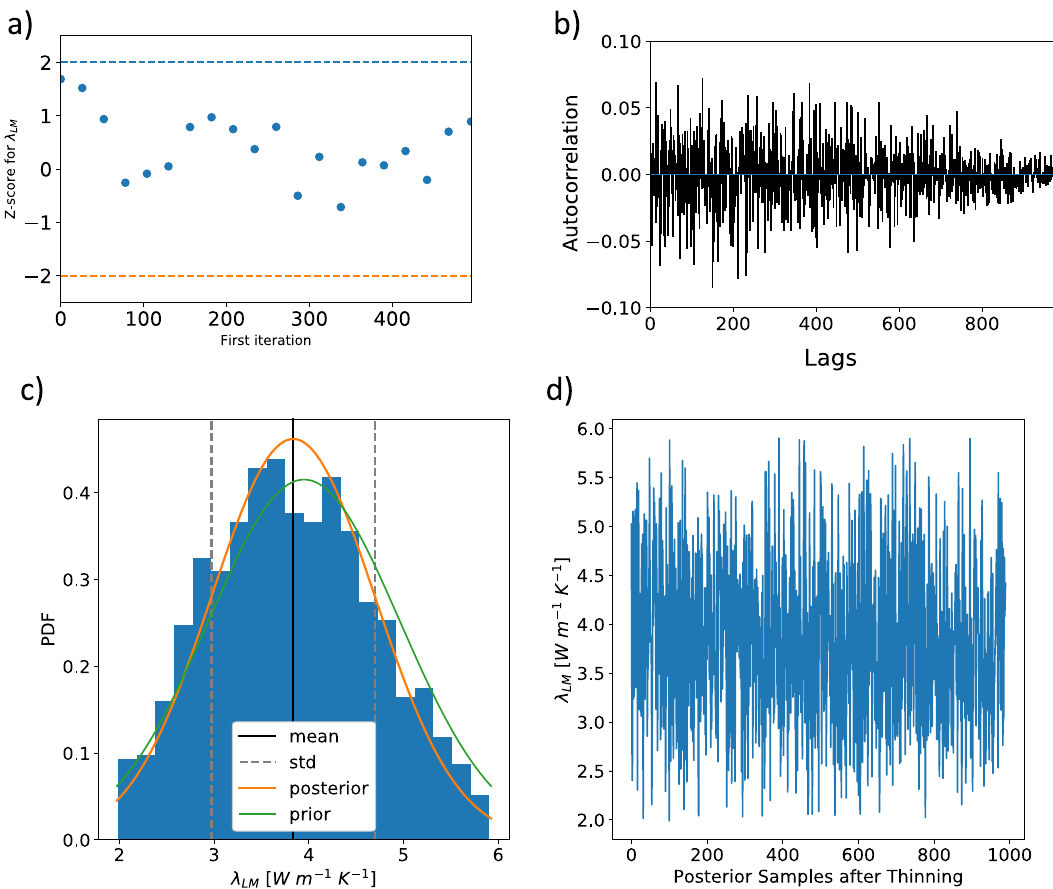
Figure 3. Posterior analysis of the lithospheric mantle (LM) as an example. The remaining posterior analyses figures are found in the Supplementary Material. Shown are the ( a ) Geweke Plot ( b ) autocorrelation, ( c ) posterior parameter distributions, and ( d ) the